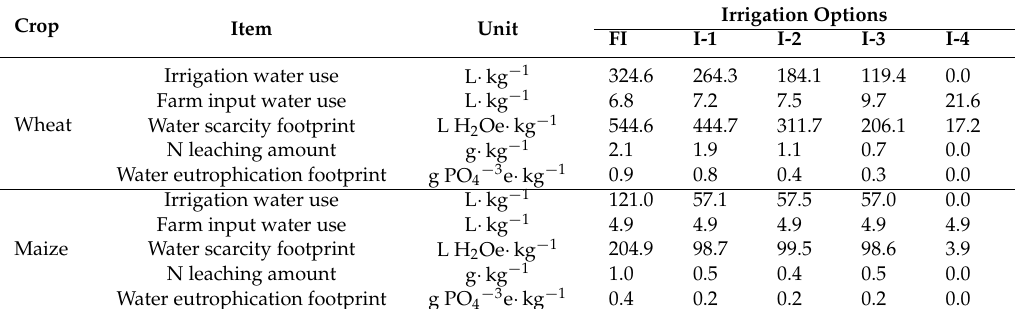
Table 4. Water scarcity footprints and water eutrophication footprints of wheat and maize under